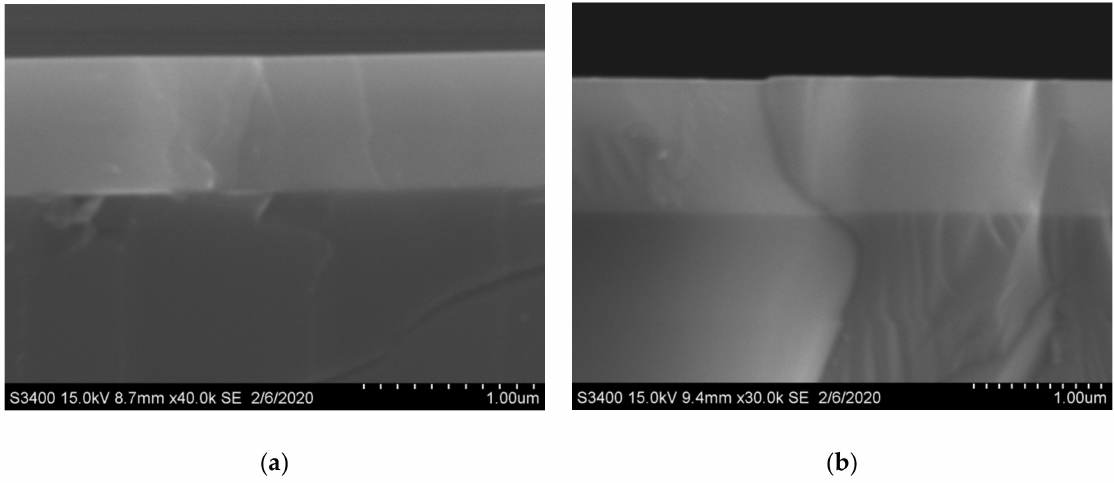
Figure 2. SEM images of the transverse fractures of the coatings 1 (100%Ar) ( a ) and 2 (85%Ar + 15%N 2 ) ( b ). The analysis of the SEM images of the transverse fractures of the coatings deposited on silicon wafers suggests that all investigated coatings have a dense, defect-free structure. Both ZrB 2 and Zr-B-N coatings have a higher density as compared to the industry-standard two-component coatings [46,47]. The SEM-derived growth rate of the coatings was 52 and 49 nm/min in case of deposition in Ar and Ar + N 2 , correspondingly. According to XRD analysis, the only crystalline constituent of coating 1 is the ZrB 2 phase with hexagonal lattice (JCPDS 89–3930). XRD patterns show pronounced reflexes (001), (100), (101), (002) and (102) of h-ZrB 2 (Figure 3).